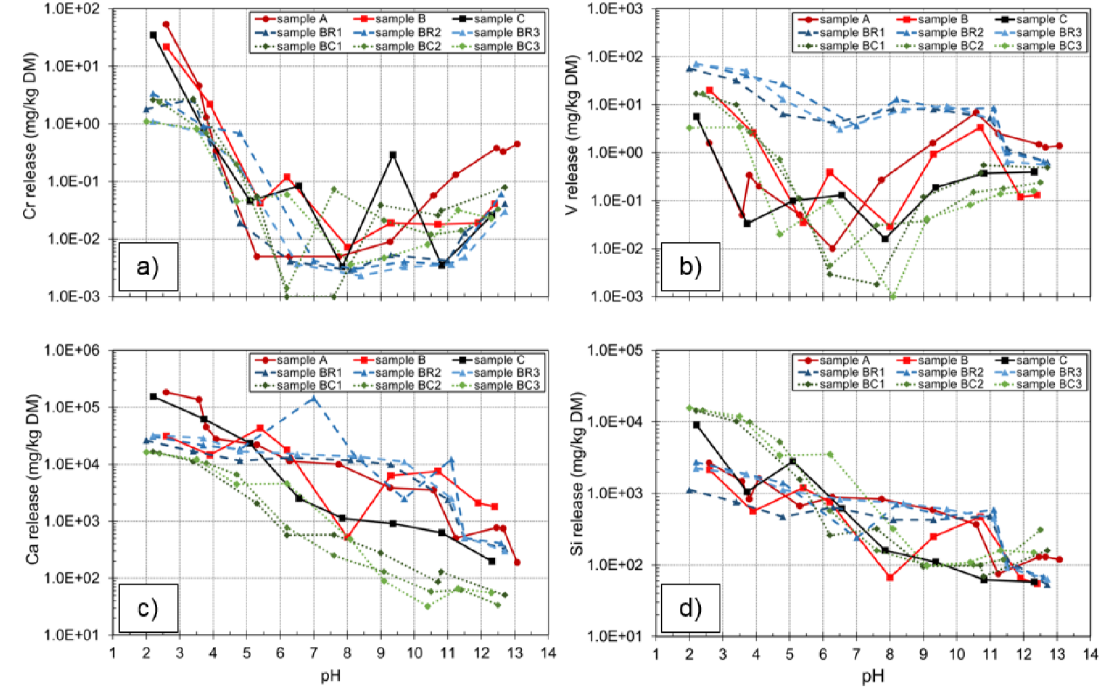
Figure 5. pH-dependent leaching behavior. ( a ) Cr, ( b ) V, ( c ) Ca, and ( d ) Si for original samples A, B, C and remelted samples BR1–3 as well as for remelted and modified samples